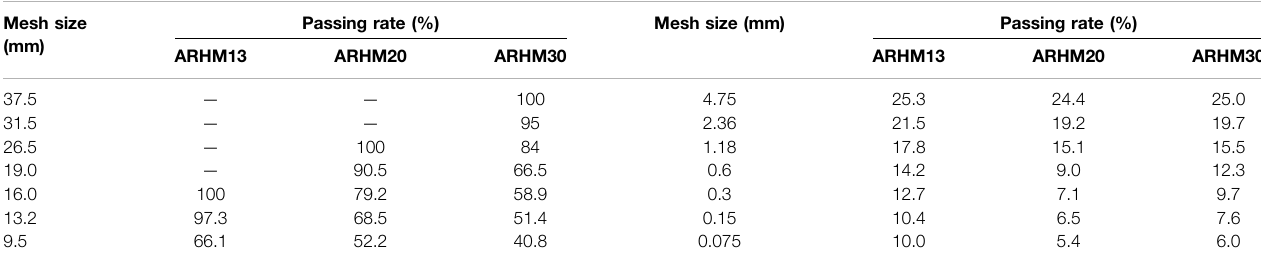
TABLE 2 | Types of rubber asphalt mixture. Mesh size (mm)